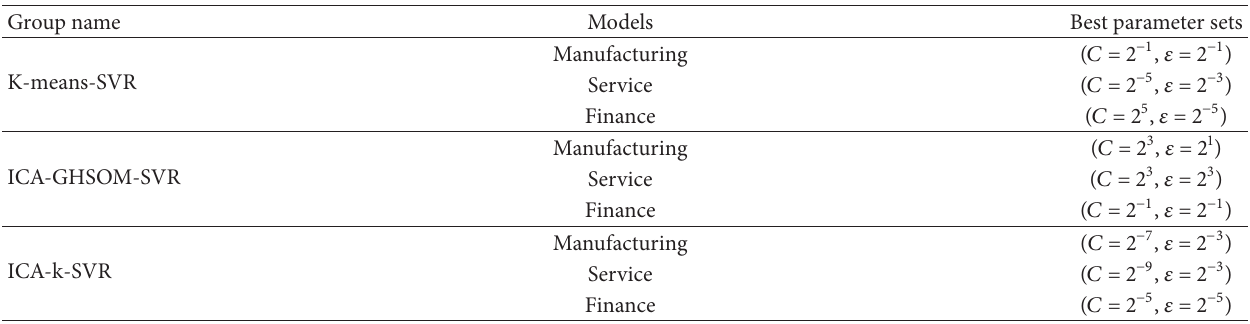
Table 7: Summary of best parameter sets of the K-means-SVR, ICA-GHSOM-SVR, and ICA-k-SVR for the three sectors.